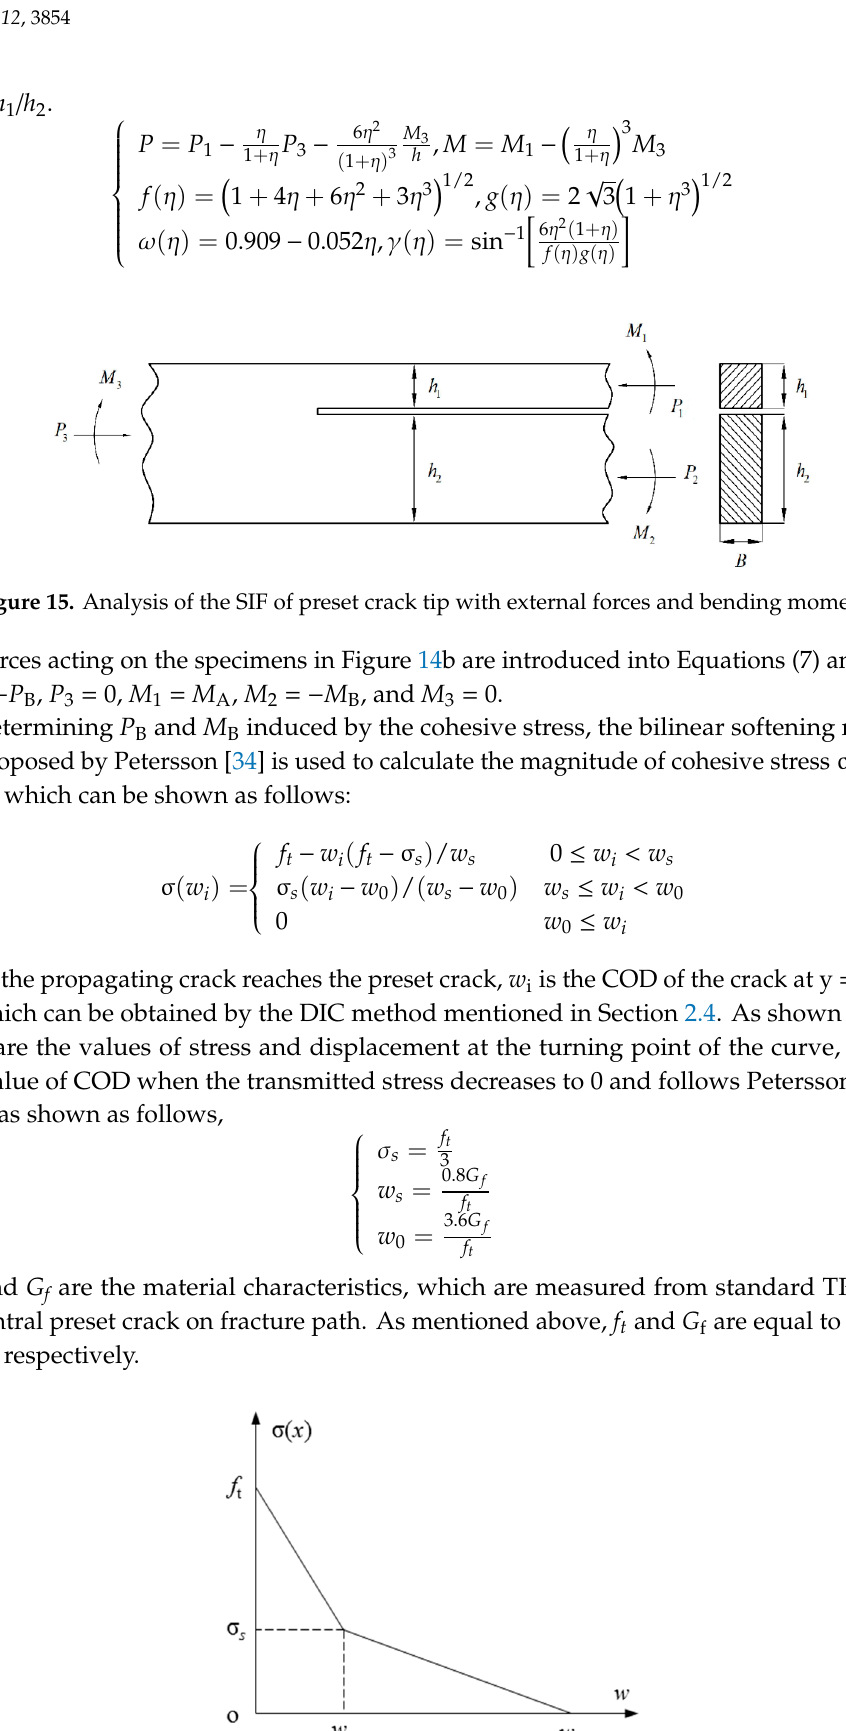
Figure 16. The bilinear softening model of the concrete.